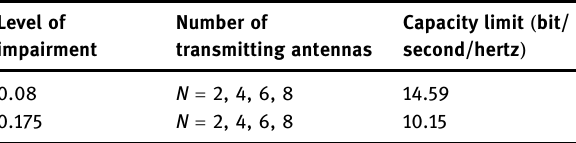
Table 2: Capacity limit values of the correlated MIMO channel with M 2 = ,